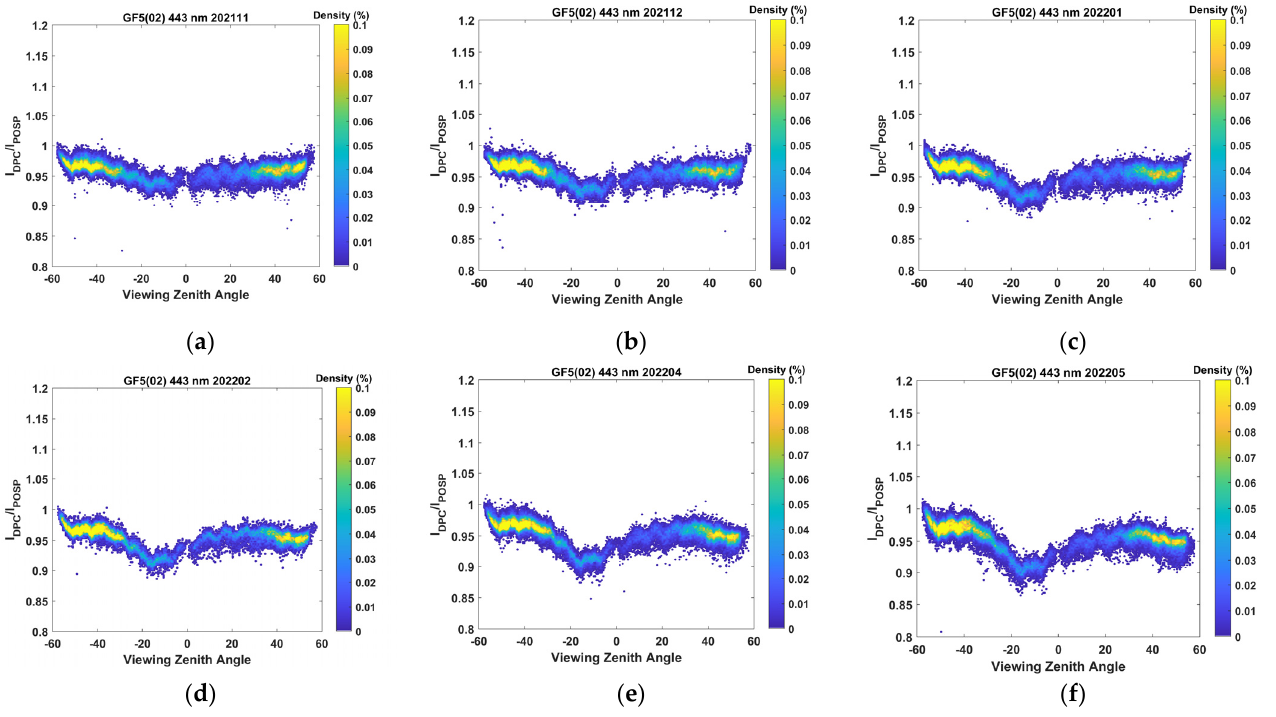
Figure 8. The ratio of DPC and POSP normalized radiance in the 443 nm band with different VZAs. These data pairs are selected for collection from ( a ) November 2021; ( b ) December 2021; ( c ) January 2022; ( d ) February 2022; ( e ) April 2022; and ( f ) May 2022 in DPC and POSP Level 1 products.